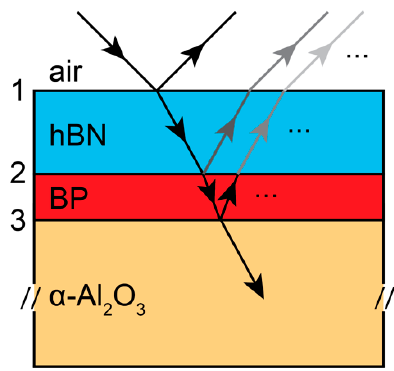
Figure 1. Schematic diagram of multi-layer system under study: air, 15 nm of hBN, 1–5 layers of black phosphorus (BP) and a thick substrate of 𝛼 -Al 2 O 3 [25]. Input and output wave are indicated directionally by arrows, where only a few reflected waves from each interface are indicated. The incident angle is shown as oblique for clarity (normal incidence in experiment).